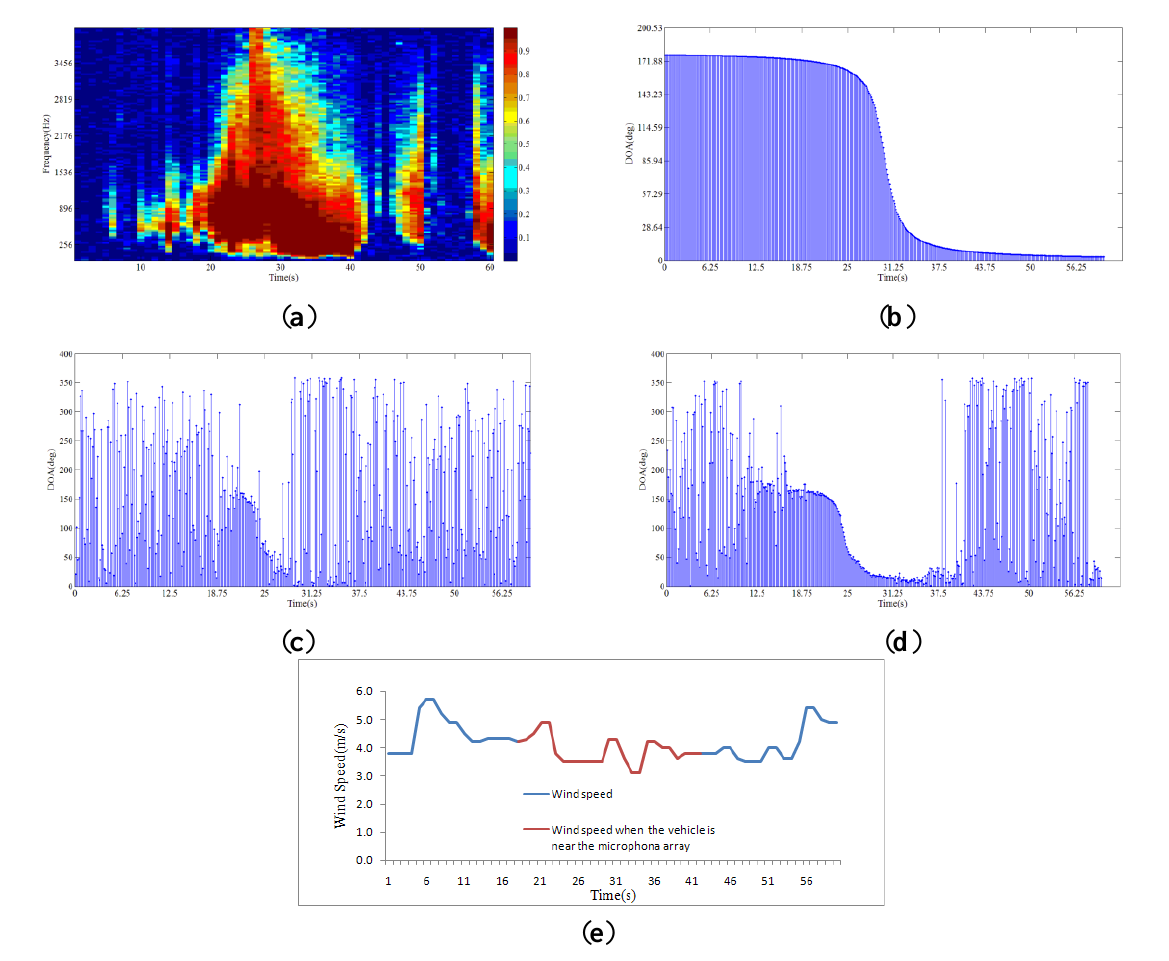
Figure 9. ( a ) Spatial coherence of the array signal in 1 minute; ( b ) ideal DOA of a car passing a microphone array; ( c ) DOA estimation with MUSIC algorithm using the entire